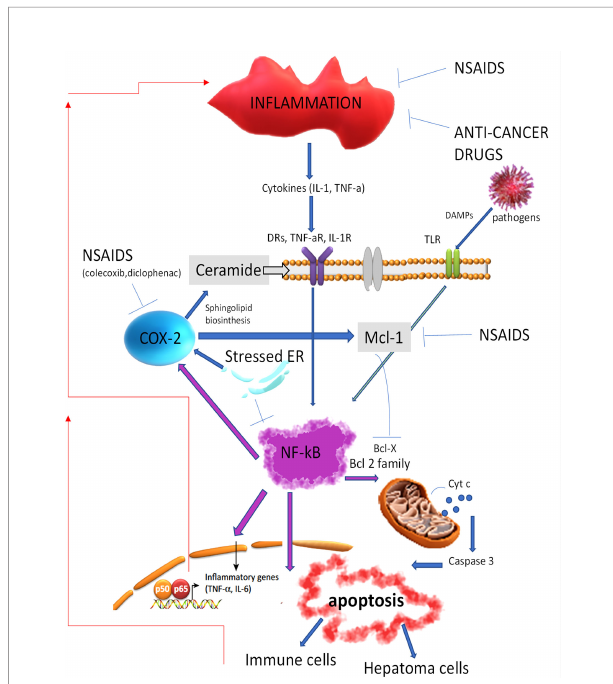
FIGURE 1 | Non-steroidal anti-in fl ammatory drugs and anticancer drugs by inhibiting in fl ammation reduce the activation of the NF-kB signaling, resulting in the apoptosis cell death and the activation of the immune cell response. DRs, death receptors; NSAIDs, non-steroidal anti-in fl ammatory drugs; NF-kB, nuclear factor-kB; BCL-2, antiapoptotic B-cell lymphoma; Cyt c, cytochrome C. TNF- aR, Tumor necrosis factor receptor alfa; IL-1R, Interleukin-1 receptor; DAMPs, Damage-associated molecular patterns; TLR, Toll like receptor; NSAIDS, Non- steroidal anti-in fl ammatory drugs; COX-2, Cyclooxygenase-2; Mcl-1, Induced myeloid leukemia cell differentiation protein; ER, endoplasmic reticulum; Bcl-x, Apoptosis regulator Bcl-extra; IL-6, Interleukin